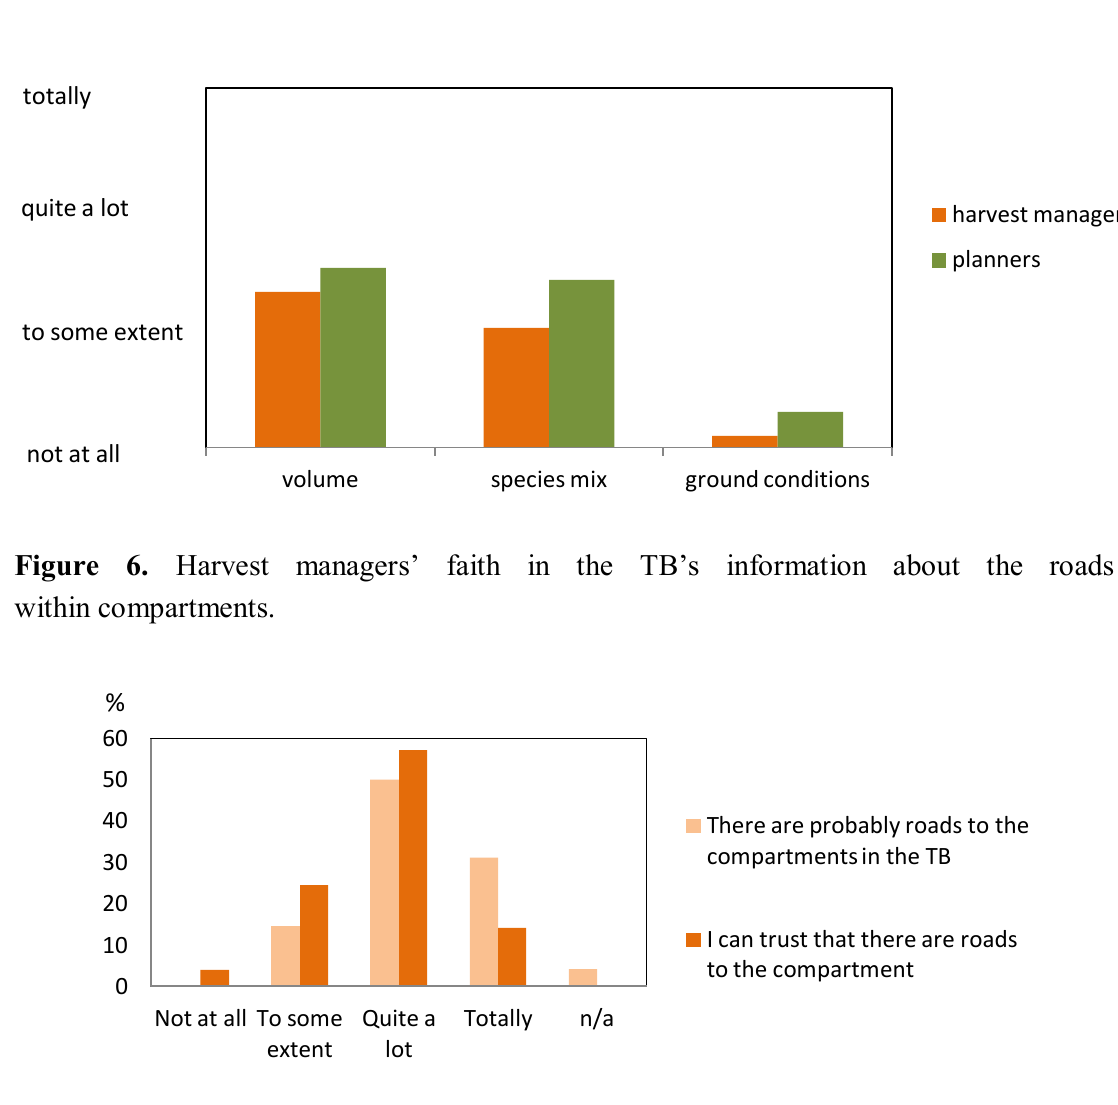
Figure 5. Tolerance for errors in information relating to three different properties of compartments within the TB.